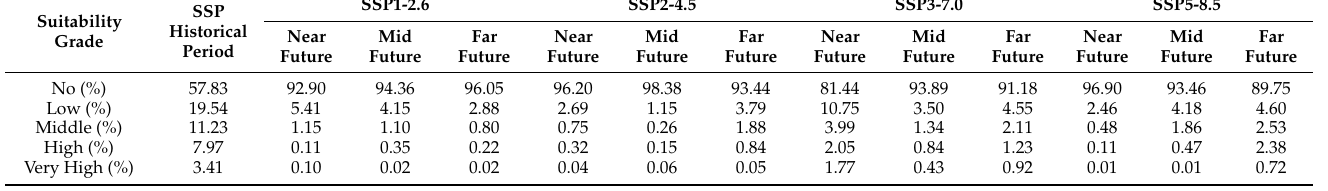
( b ) Figure 2. Predicted habitat suitability under current condition: ( a ) A. pictum ; ( b ) Q. acuta .